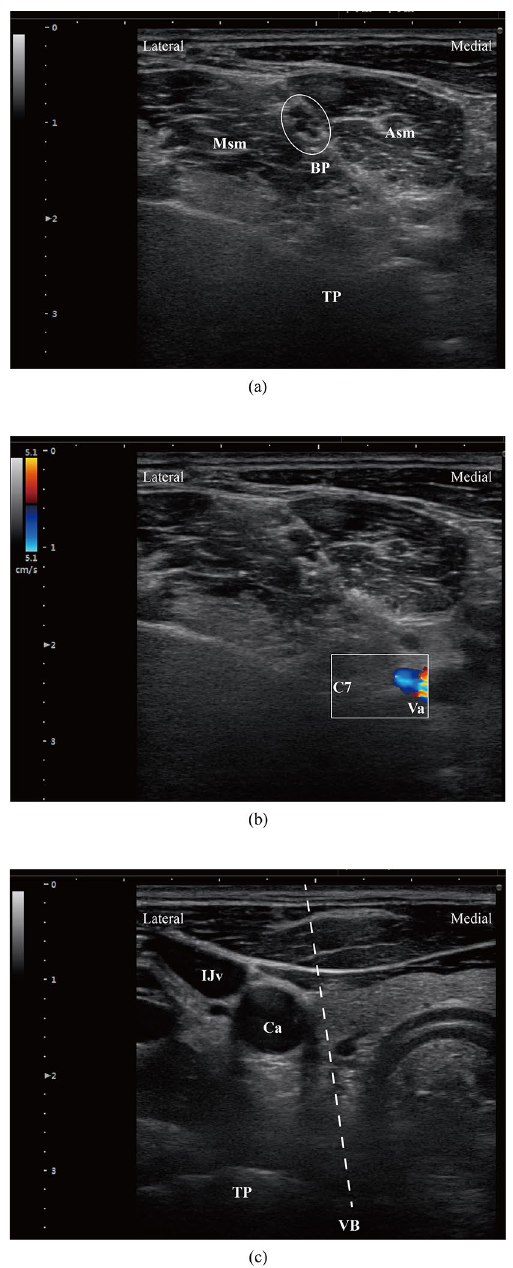
Figure 3. Ultrasonic imaging for C6/7-disc level. ( a ) Transverse process is straight at C7 level, the brachial plexus can be recognized by its grape-like shape. ( b ) C7 nerve root is slightly lateral to the vertebral artery in the short-axis ultrasound image. ( c ) Cannulation access of C6/7 intervertebral disc space. Asm anterior scalene muscle, Msm middle scalene muscle, TP seventh transverse process, VB seventh vertebral body, BP brachial plexus, C7 seventh cervical nerve root, Va vertebral artery, IJv internal jugular vein, Ca carotid